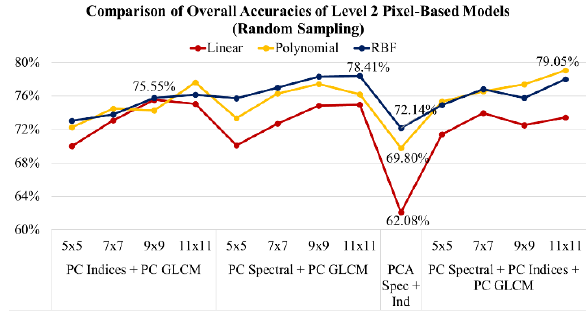
Figure 10. Overall accuracies of the Level 2 random models